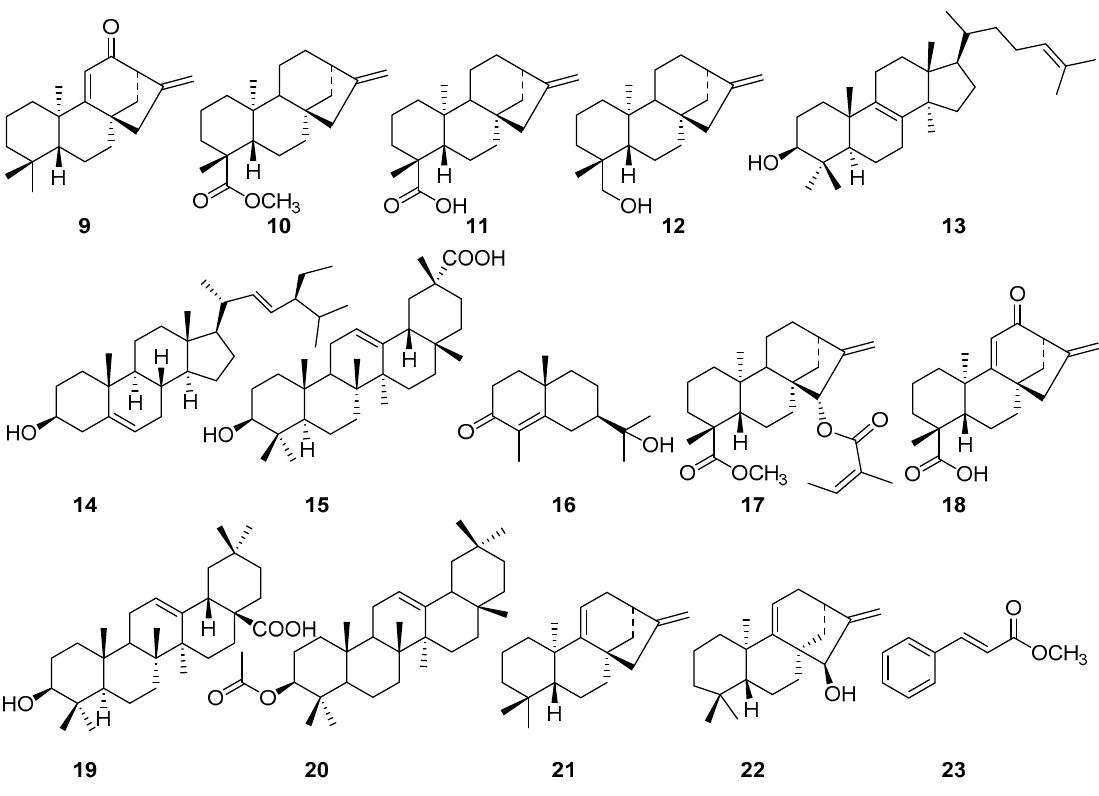
Figure 3. Structures of compounds 9 – 23 .